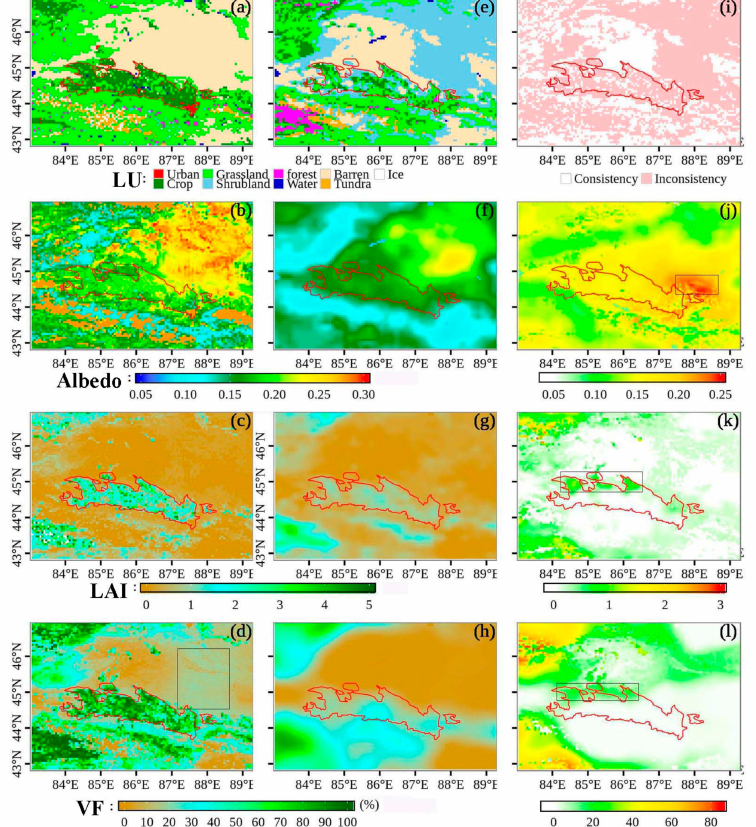
Figure 2. Comparison between actual LU ( a ), albedo ( b ), leaf area index (LAI) ( c ), and green vegetation fraction (VF) data ( d ) and the corresponding default data ( e – h ), with differences shown in ( i – l ). The red line indicates the border of the key oasis areas, and the black rectangle indicates the region strongly influenced by human activities in oases and desert areas over the past 20